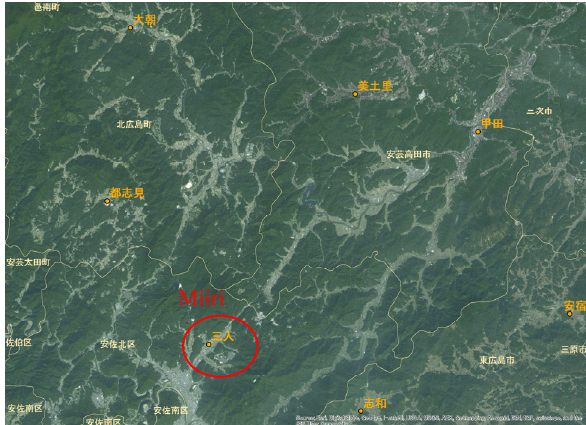
Figure 10. Result of taking rainfall information of the X-band MP radar into GIS (2014.08.20